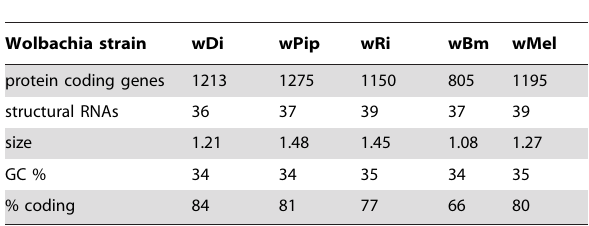
Table 2. Comparison of genome properties for Wolbachia endosymbiont of Diaphorina citri (wDi) with the complete genome sequences for four Wolbachia strains a .